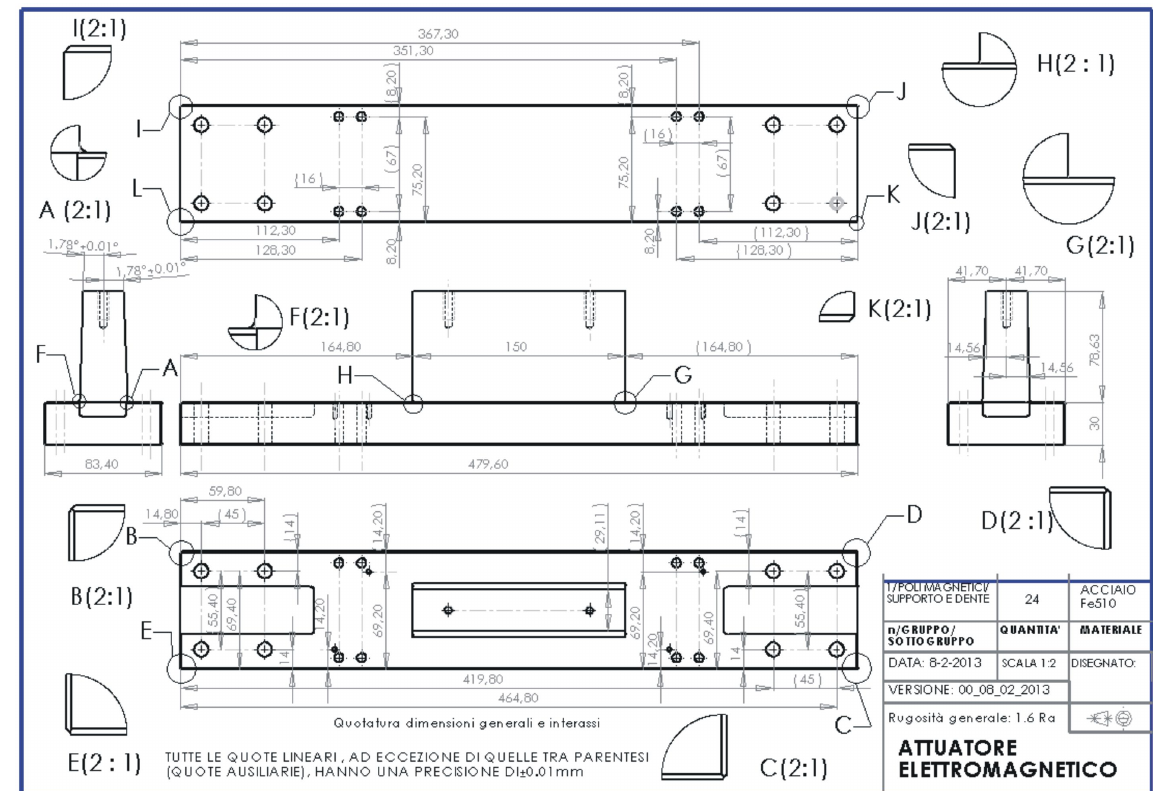
Figure 8: Ferromagnetic core and base enbloc.